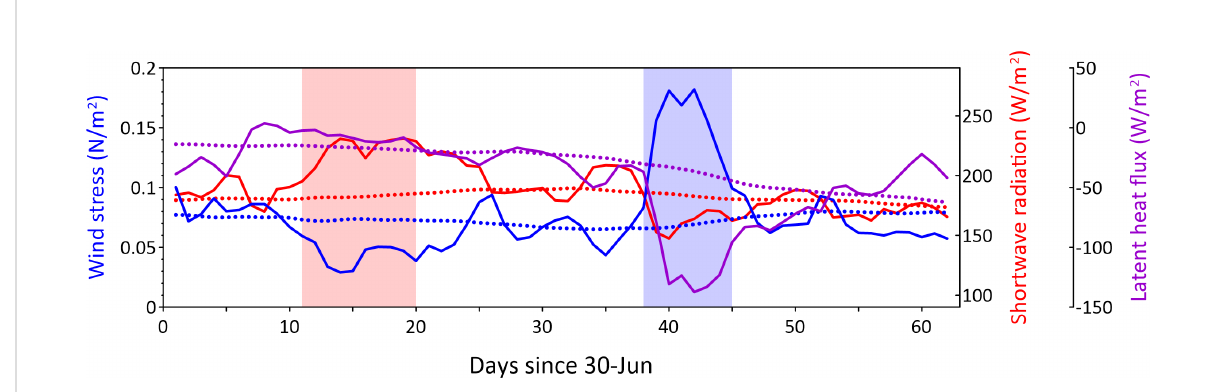
FIGURE 10 Time series plots of 2021 (solid) and climatological (dotted) forcing data for one-dimensional model. Red, blue, and purple indicate shortwave radiation, wind stress, and latent heat fl ux,